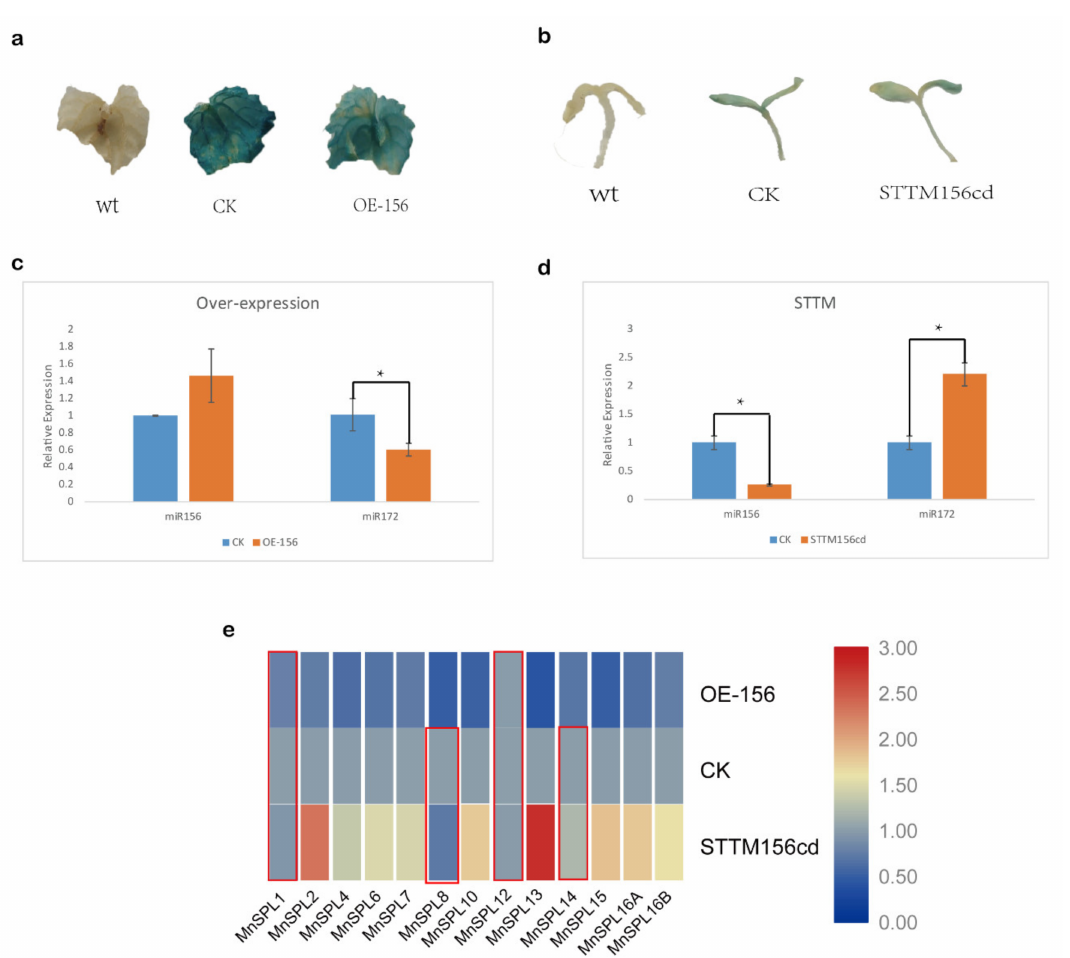
Figure 6. Altered miR156 expression in mulberry. ( a , b ) GUS staining of mulberry leaves and seedlings, wt: wild type; CK: control check, the empty pCAMBIA1301 vector; OE-156: over-expression of miR156; STTM 156cd: repression of mno-miR156c and mno-miR156d by short tandem target mimic (STTM). ( c , d ) The expression level of miR156 and miR172 under over-expression and reduced expression of miR156 in mulberry. Values represent the mean ± SD of three biological replicates and were statistically analyzed (independent-samples t -test): *, p < 0.05. ( e ) The expression profile of SPL genes under over-expression and reduced expression of miR156 in mulberry. Red box indicates there were no significant differences between these samples. Heatmap was finished using TBtools, and the min–max normalization method was utilized to normalize the